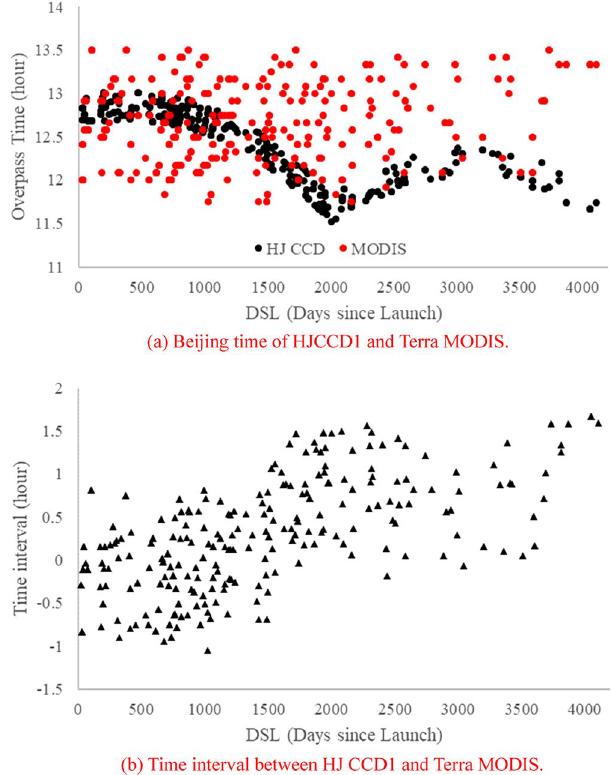
Figure 6. The time difference between the two satellites overpassing Dunhuang.